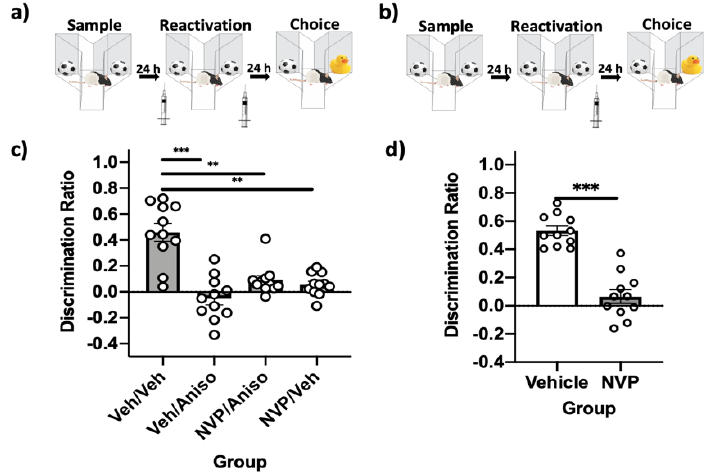
Figure 3. GluN2A-containing NMDARs in PRh are involved in reconsolidating, but not destabilizing, relatively recent object memories. ( a ) Standard SOR parameters, with intra-PRh infusions performed immediately prior to reactivation to target destabilization and prevent the impairing effects of post-reactivation infusion of anisomycin. ( b ) Standard SOR parameters, where only post-reactivation intra-PRh infusions were performed to target reconsolidation. ( c ) Choice-phase DRs. Only the veh–veh group had a choice DR that differed from its respective sample DR, suggesting this was the only group with intact memory. This group had significantly greater performance than all other groups. ( d ) Choice-phase DRs. The NVP group choice DR did not differ from its respective sample DR, suggesting lack of recognition memory, while memory was significantly impaired compared to the veh group. Bars are mean DR ± SEM; ** p < 0.01, *** p < 0.001.